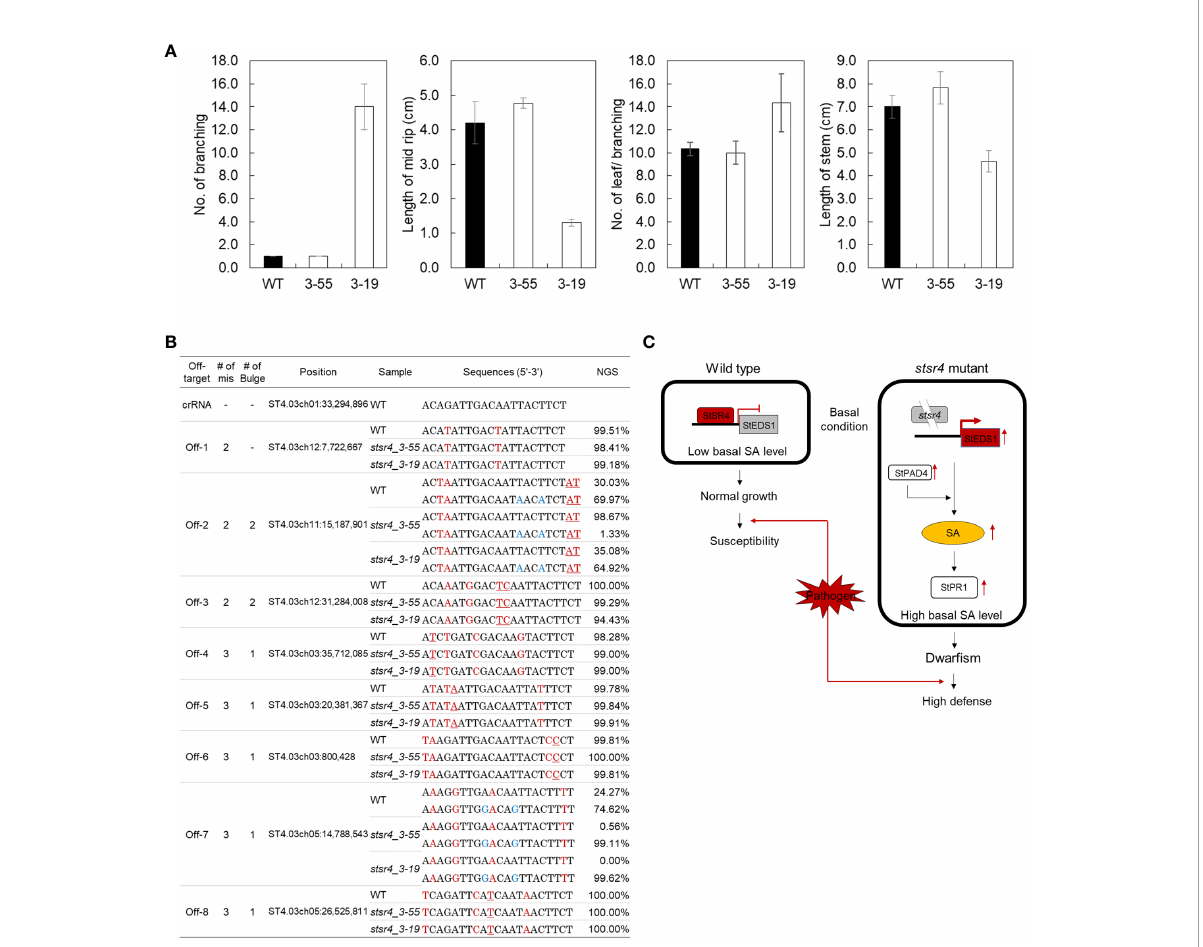
FIGURE 6 In vivo phenotype assays and off-target analysis of two mutants showing improved pathogen resistance. (A) Measurement of branch number per plant, midrib length, leaf number per branch, and stem length in wild type and stsr4_3-55 and stsr4_3-19 mutants. The plants were grown in a greenhouse under 16 h light/8 h dark photoperiod for 1 month. Values represent mean± SE of four biological replicates. Asterisks indicate signi fi cant differences (Student ’ s t -test; * p <0.05). (B) Analysis of off-target editing in two stsr4 mutants. Eight candidate off-target sequences were analyzed by PCR, followed by targeted deep sequencing (Read counts > 100). The mismatched nucleotides between the on- and off- target sequences are indicated in red, and the bulges are underlined red. Blue sequences represent SNPs. (C) Model explaining the basis of increased SA levels and pathogen resistance in potato, based on the suppression of StSR4 expression, and consequently increased expression of StEDS1 and